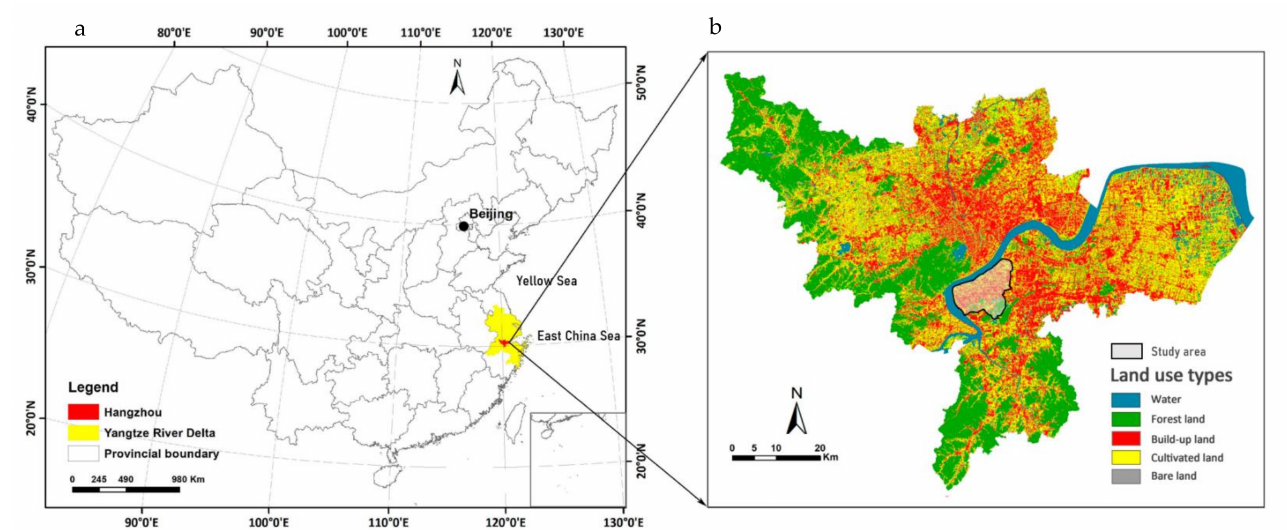
Figure 1. ( a ) Map of China, ( b ) location and land-use types of the study area. Note: The study area is a National High-Tech Industrial Development Zone, and the degree of urbanization has been already very high. In Figure 1b, more than 90% of the cultivated land in the study area is regarded as park land for unplanned built-up land by the government and has been covered by landscape plants such as lawns and trees. It is thus regarded as park land in this study too. The information of Figure 1b comes from City University of Hong Kong.